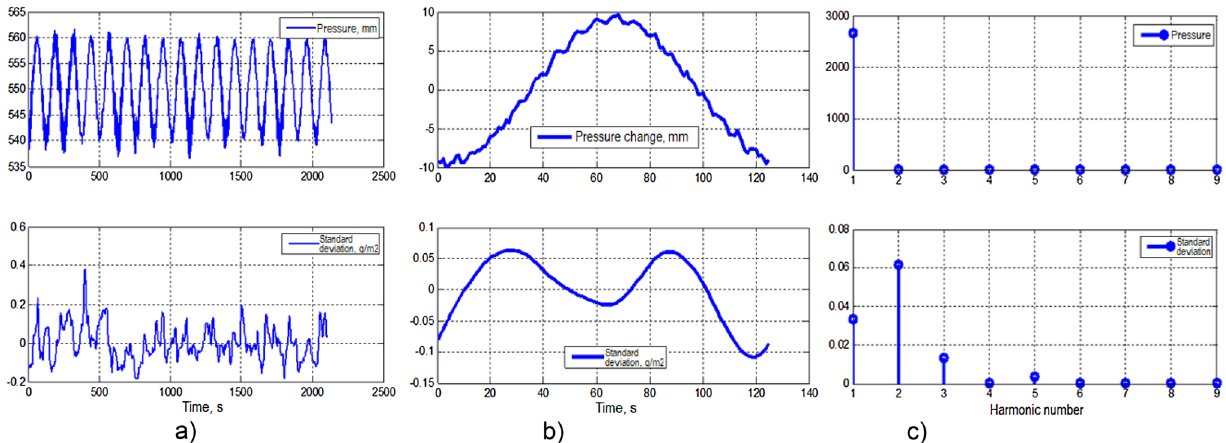
Fig. 6 Simulation results with an average head value equal to the optimal one (550 mm): a input harmonic and output noisy signals of an inertial extremal object; b results of synchronous accumula-